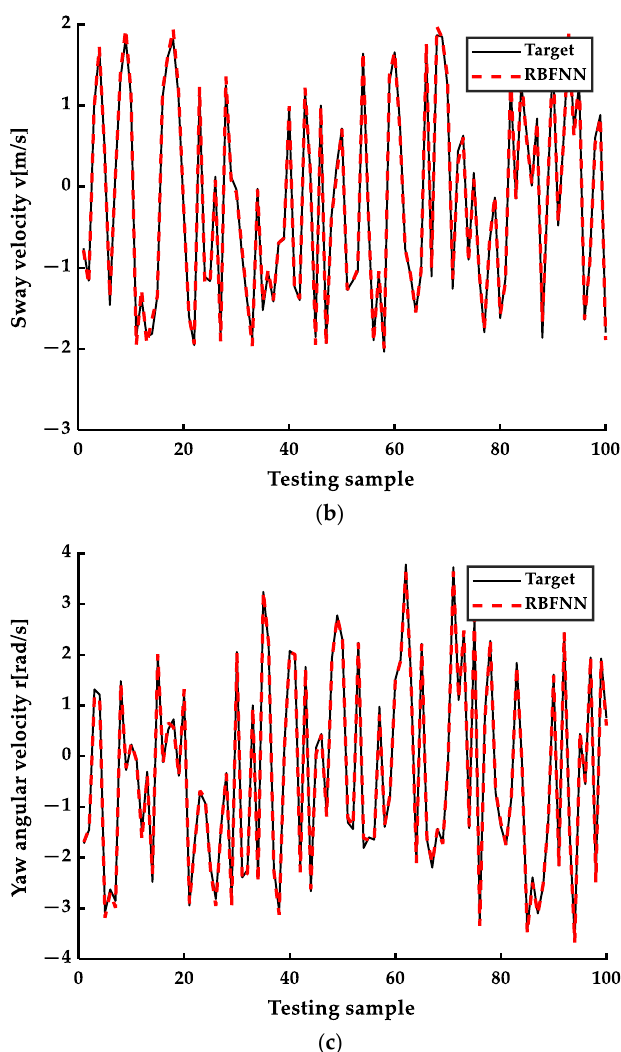
Figure 6. Comparison chart of actual value and predicted value of test set: ( a ) The actual and predicted values of surge velocity; ( b ) The actual and predicted values of sway velocity; ( c ) The actual and predicted values of yaw angular velocity.